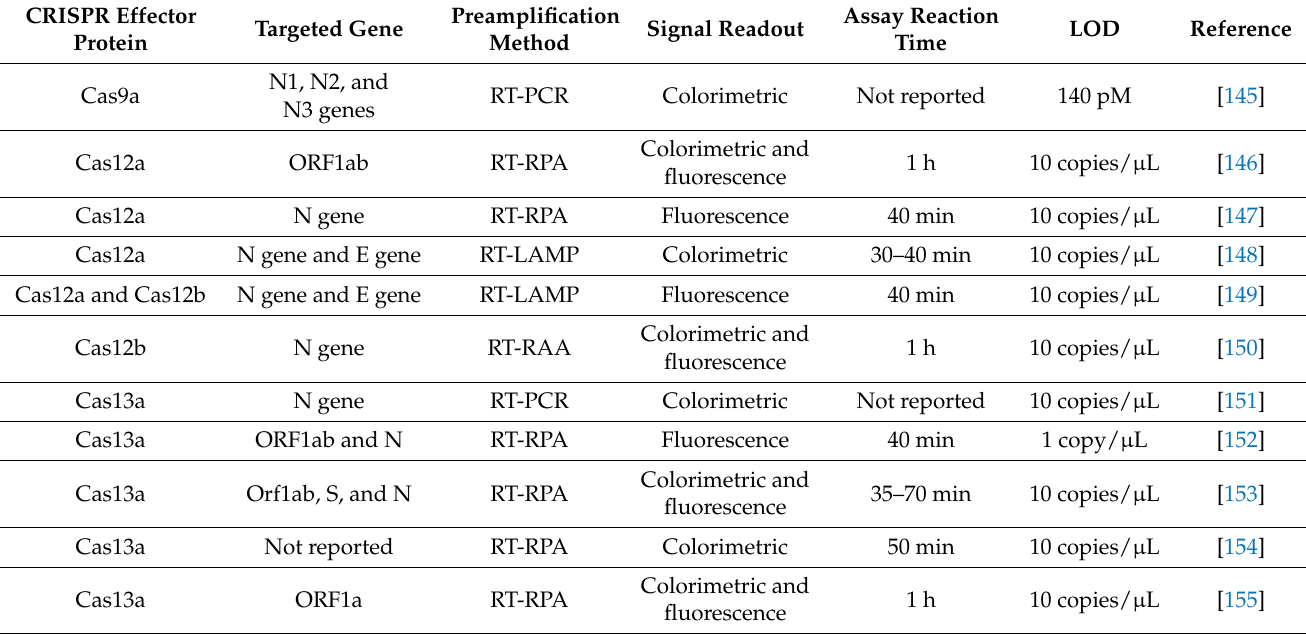
Table 2. Overview of CRISPR protein that can be used to detect SARS-CoV-2